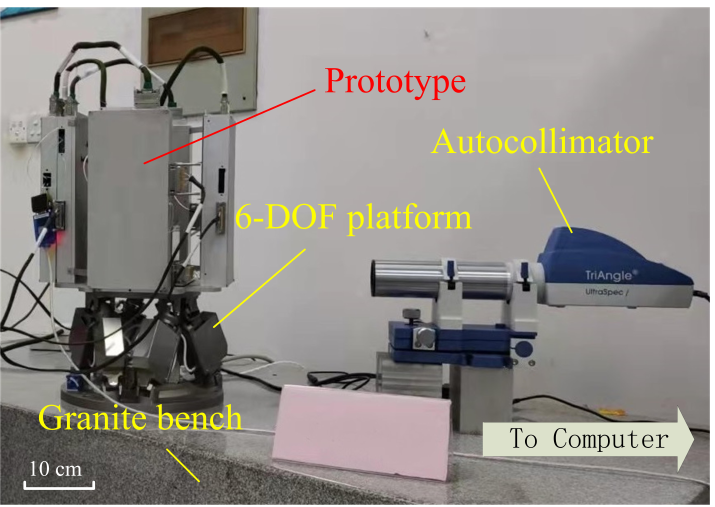
Figure 5. The instruments’ experimental setup includes the prototype, the positing platform, the autocollimator, and the granite